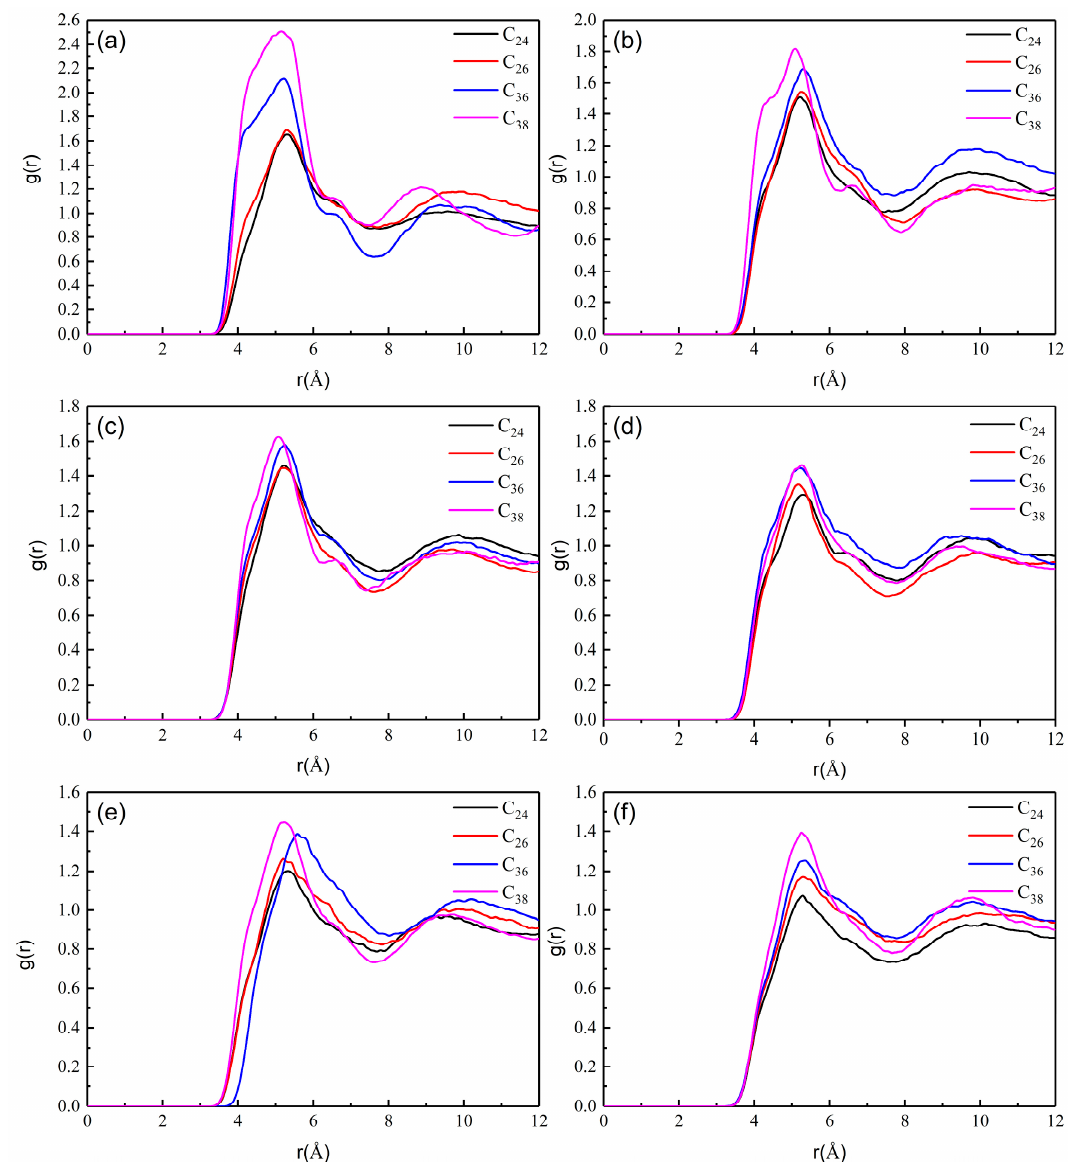
Figure 6. RDF of wax molecules at ( a ) 283.15, ( b ) 293.15, ( c ) 303.15, ( d ) 313.15, ( e ) 323.15 and ( f ) 333.15 K.